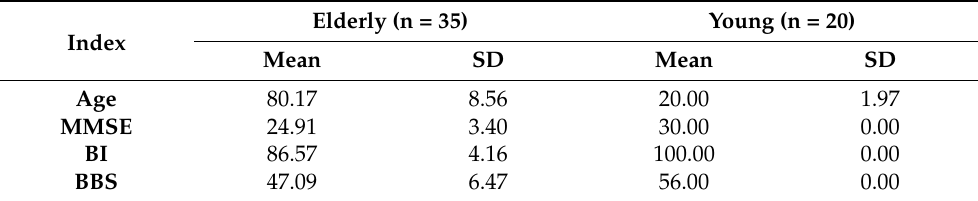
Table 1. Demographic characteristics of the samples (N = 35 + 20 =